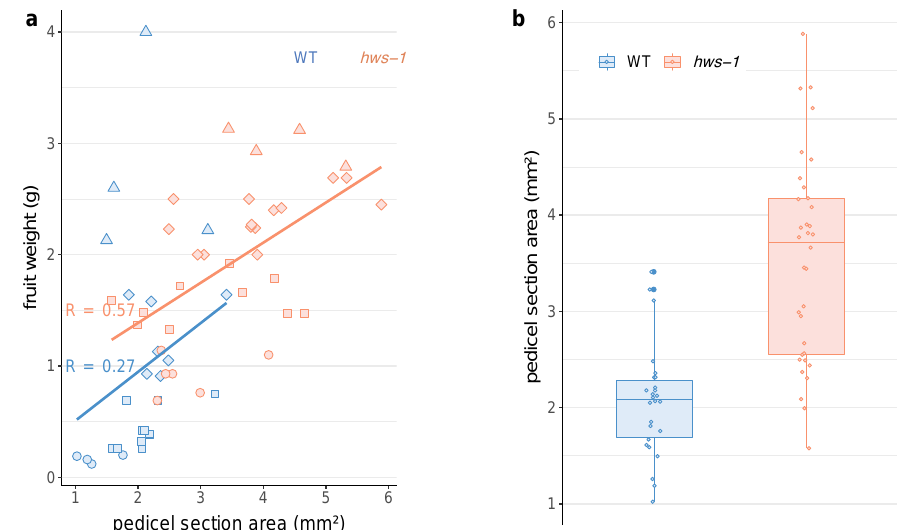
Figure 1. The larger fruits of hws-1 are associated with wider pedicels. ( a ) Pedicels carrying fruits aged from 7 to 16 DAA ( ◦ : 7~9; (cid:3) : 11~12; (cid:5) : 13~14; (cid:77) : 15~16) were cut halfway between the fruit and the abscission zone. ( b ) Pedicels of hws-1 are markedly wider than their WT counterparts, and the differences are statistically significant with p < 0.001 in an unpaired t -test. In both ( a ) and ( b ), section areas were measured using the ImageJ software [17,18]; n =